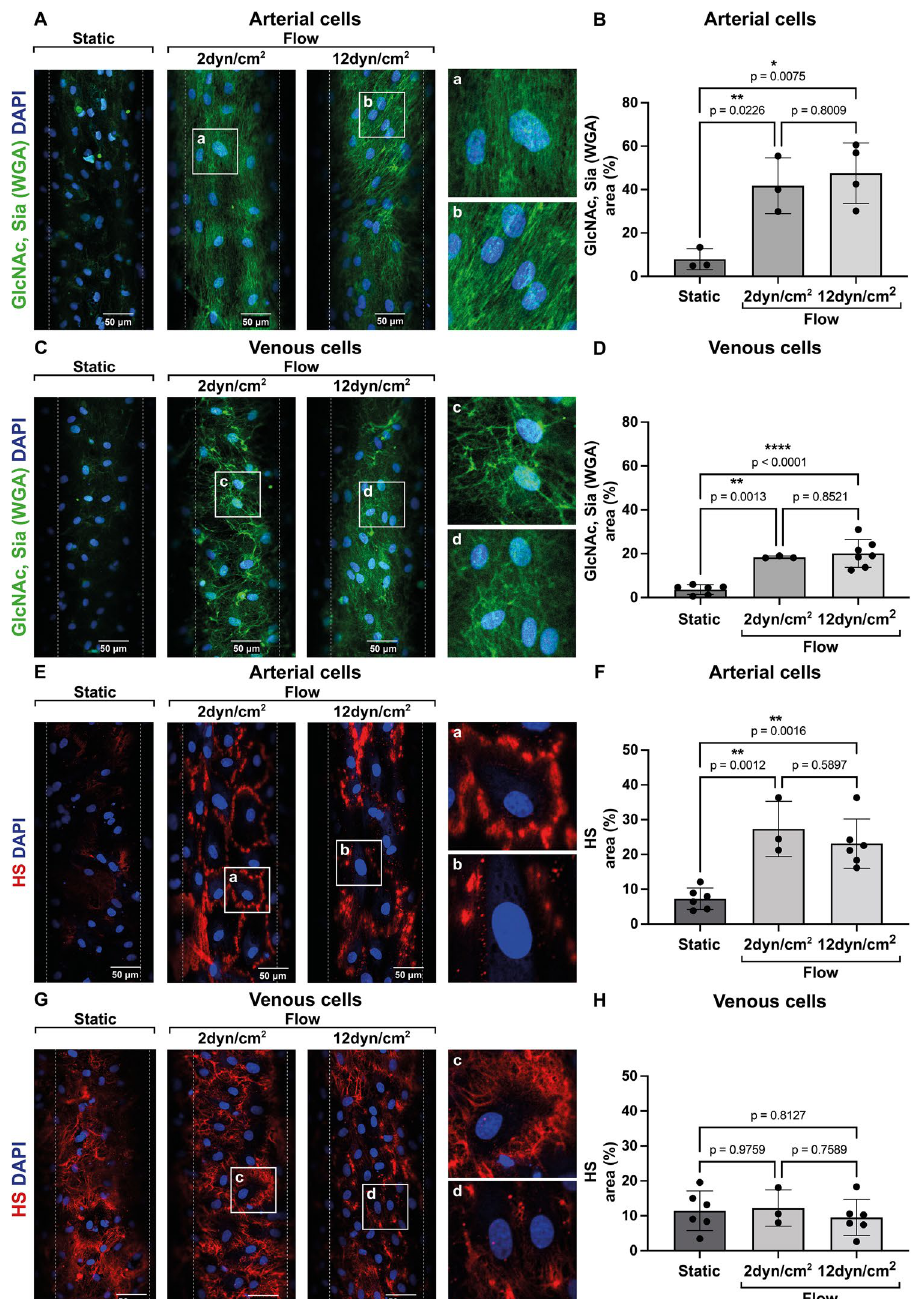
Figure 1. Influence of shear stress on glycocalyx/N-Acetylglucosamine, sialic acid and heparan sulfate coverage on arterial and venous endothelial cells. Representative images of microfluidic channels containing ( A , E ) arterial or ( C , G ) venous porcine endothelial cells cultured under static conditions, at low (2 dyn/cm 2 ) or high shear stress (12 dyn/cm 2 ). Cells were stained ( A , C ) for N-Acetylglucosamine (GlcNAc) and sialic acid (Sia) in green or ( E , G ) for heparan sulfate (HS) in red. Nuclei are shown in blue (DAPI). All images were acquired with a Zeiss LSM710 confocal microscope. Scale bar: 50 μm. ( B , D , F , H ) Coverage of glycocalyx components (GlcNAc/ Sia or HS) was calculated for each image (4 images/condition/experiment) as percentage of area positive for ( B , D ) GlcNAc and Sia or ( F , H ) for HS and, was normalized to the total number of cells/image. Data are from three or more independent experiments and 2–3 different porcine ECs donors. One-way ANOVA with multiple comparisons was used for statistical